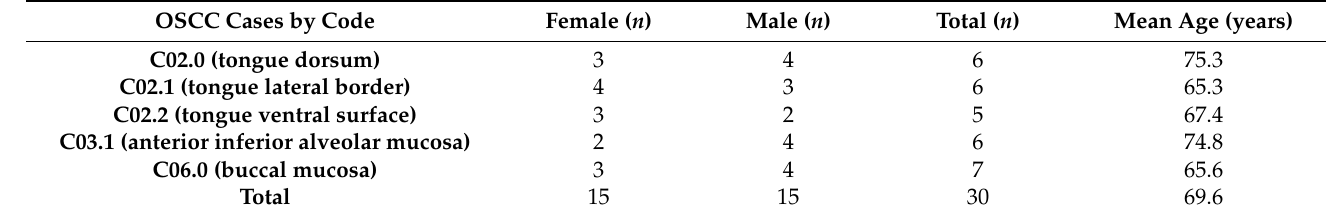
Table 2. Demographics data (gender and age) for OSCCs groups by